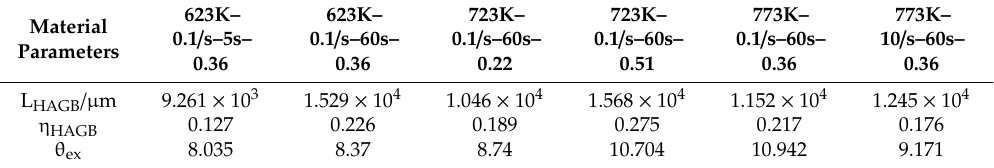
Table 1. Material parameters under di ff erent conditions after the thermal insulation stage.